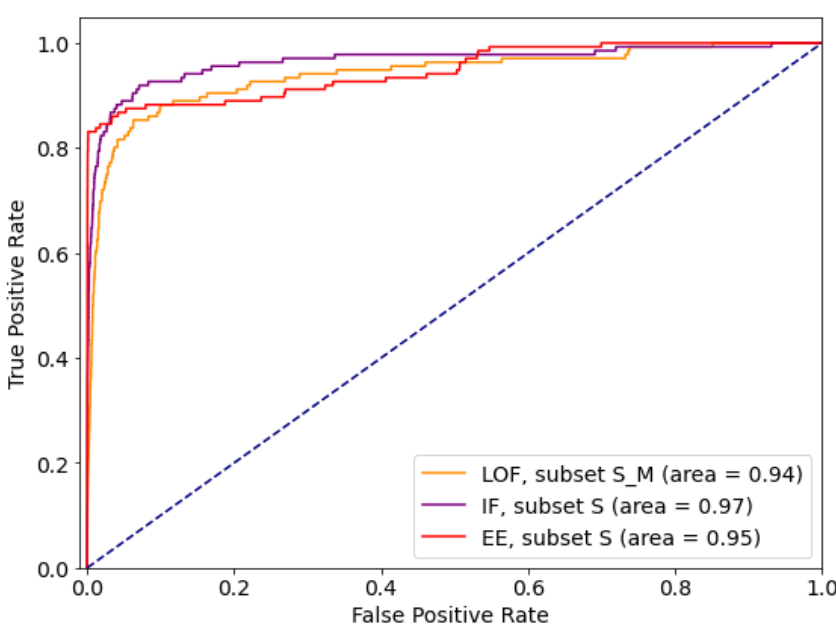
Figure 2. Extended CreditCard dataset—comparative ROC curve for outlier detection methods.